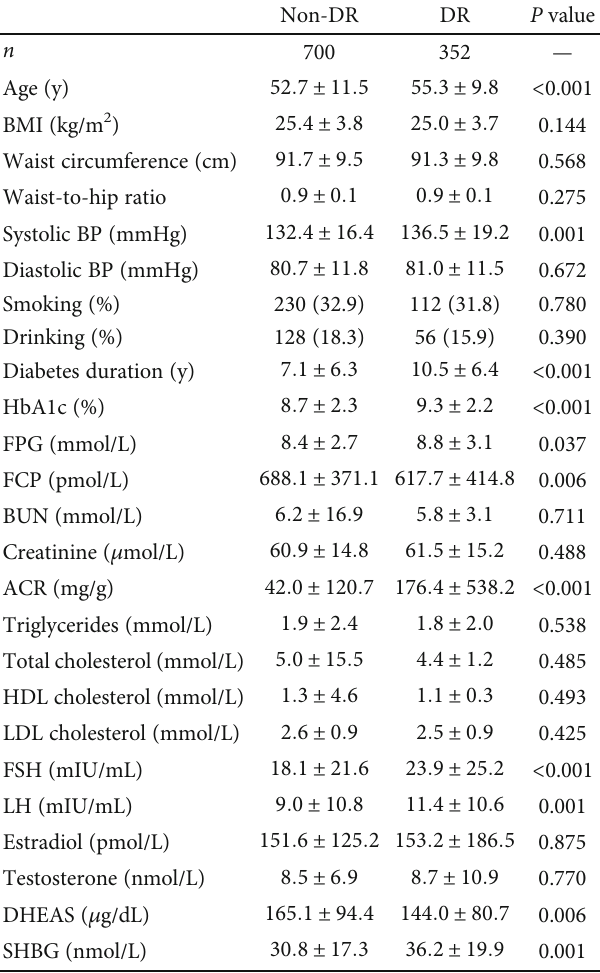
Table 1: Characteristics of subjects with or without diabetic